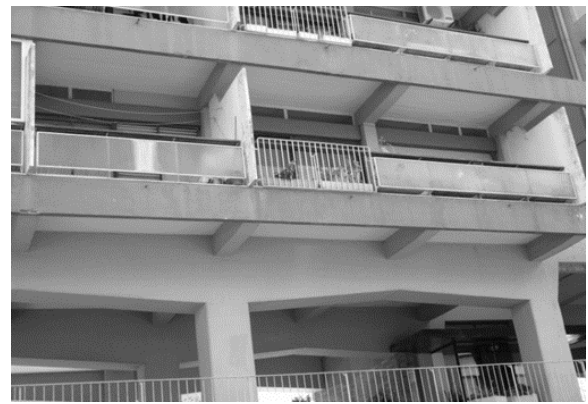
Figure 10. Detail of the principal façade.